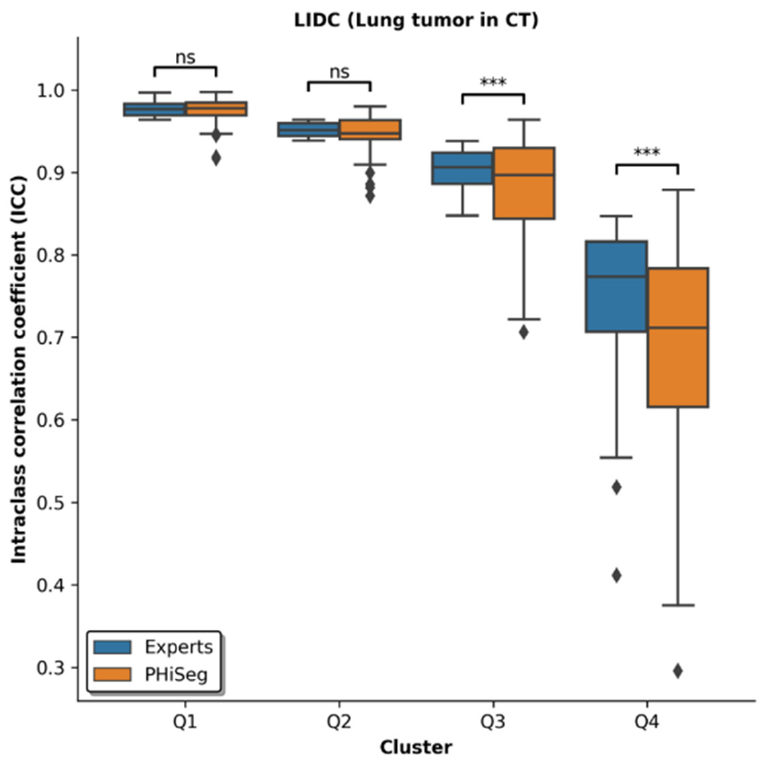
Figure 3. ICCs of radiomic features when calculated based on manual segmentations of lung lesions by four experts (blue) and 100 automatic-generative segmentation outlines generated by the pre- trained neural network PHiSeg (orange). Features were grouped into quartiles based on manual expert segmentations and Q1 indicates the 25% most stable features, Q2 the 25–50% most stable features, Q3 the 25–50% least stable features, and Q4 the 25% least stable features. Overall, ICCs were largely similar, even though the NN introduced more variability. ns: not significant, ***: p < 0.001.